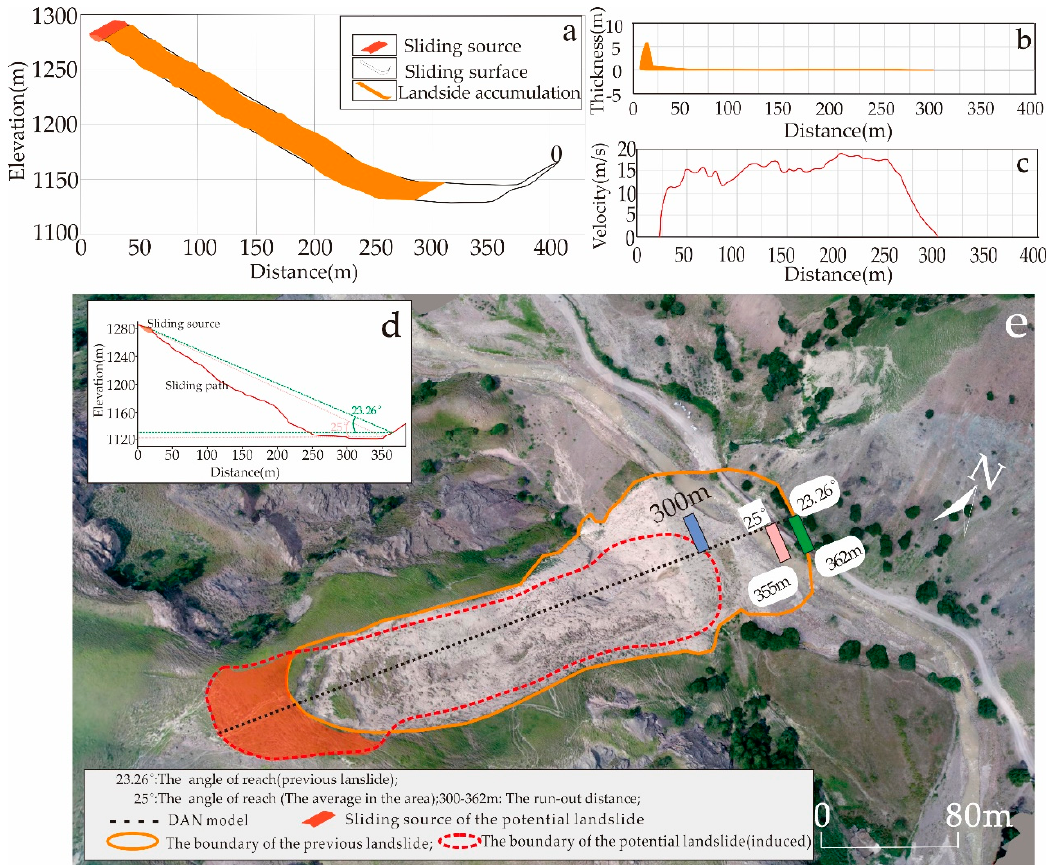
Figure 13. ( a ) The runout distance in the DAN-W. ( b ) Variation of the thickness of the unstable slope in the DAN-W. ( c ) Variation of the velocity of the unstable slope in the DAN-W. ( d )The sled model for the two different reach angles. ( e ) Maximum extent of the unstable slope runout at different methods.